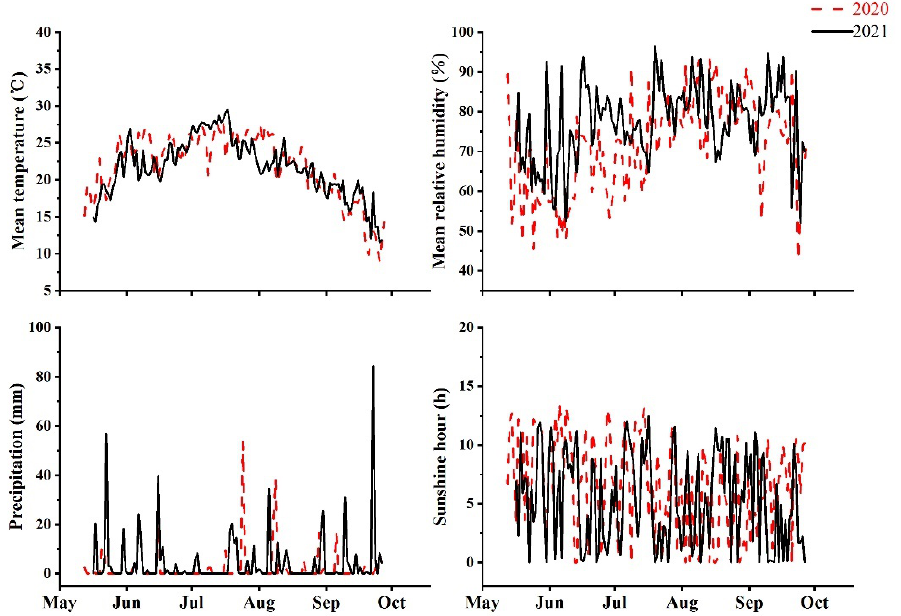
Figure 1. Mean temperature (°C), relative humidity (%), precipitation (mm), and sunshine hours (h) during the rice-growing season in 2020 and 2021.